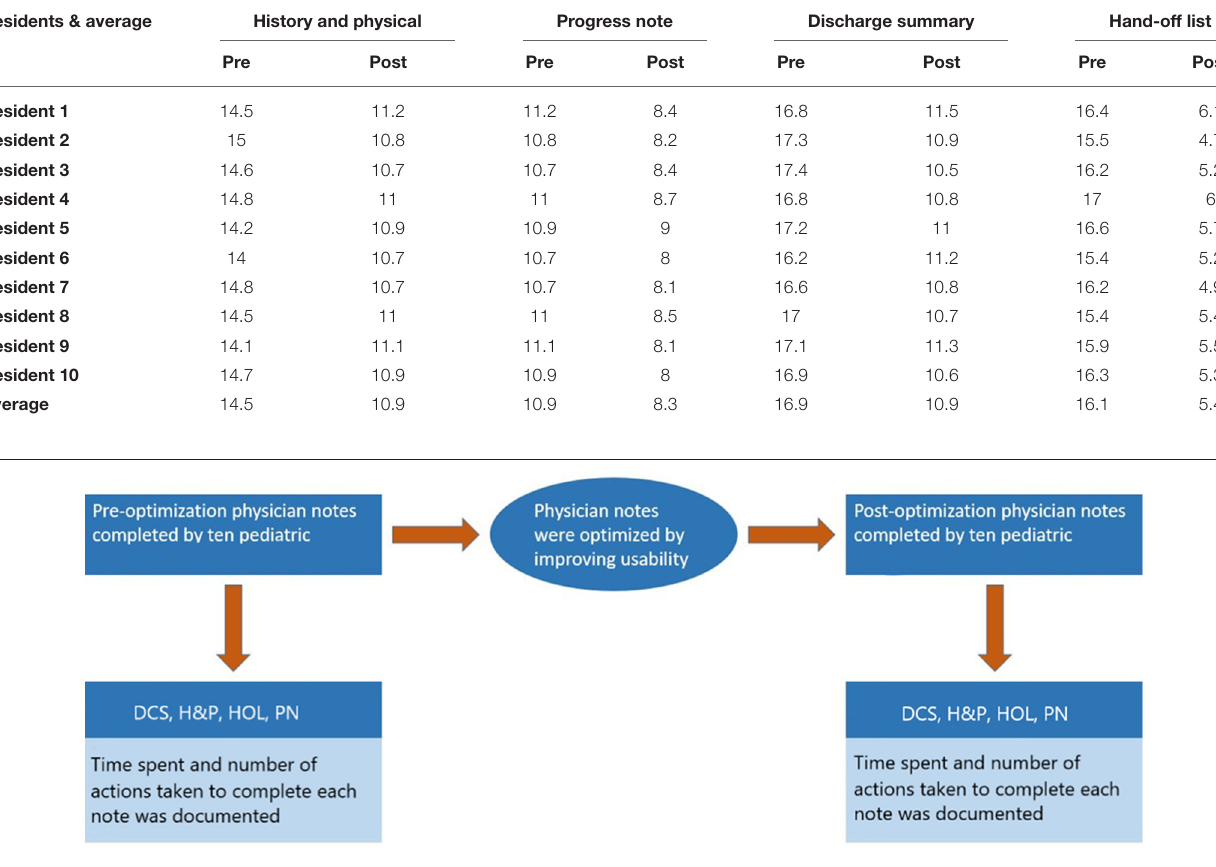
TABLE 2 | Pre-optimization and post-optimization note-completion time in min by the ten pediatric residents. Residents & average History and physical